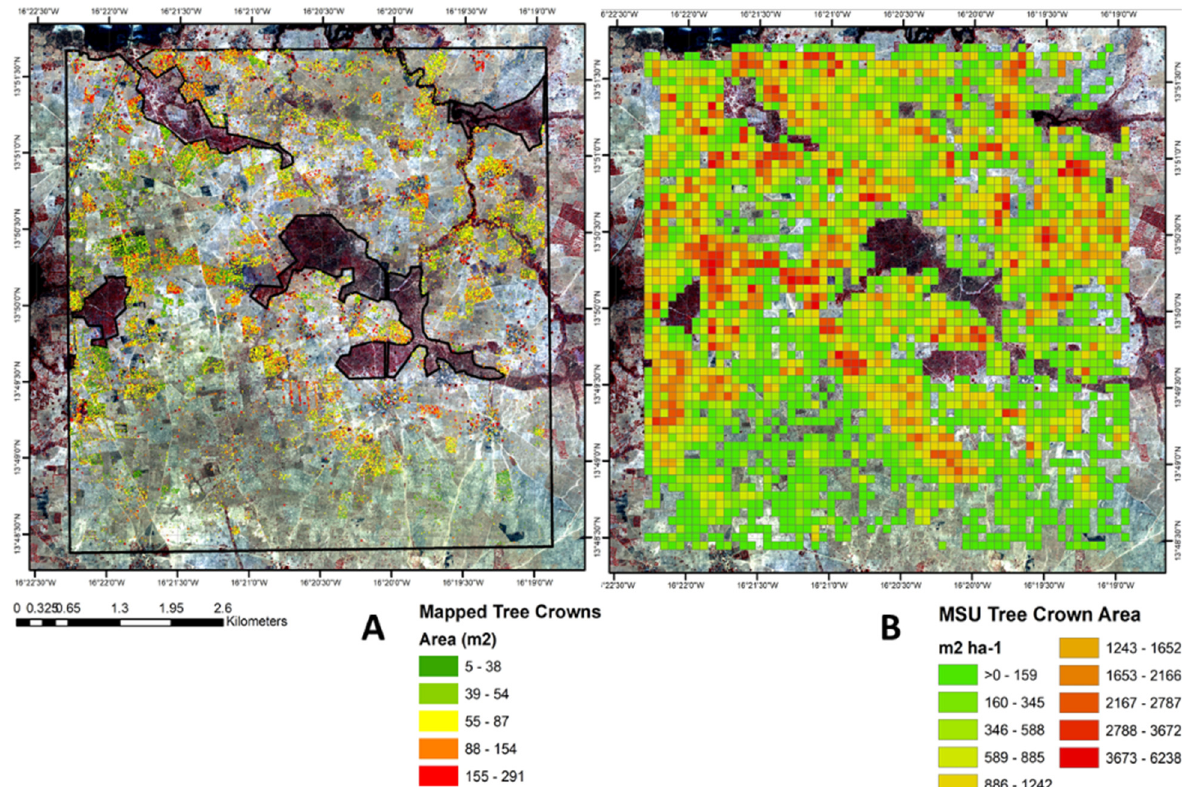
Figure 4. Tree cover mapping for the entire test site from mapping individual tree crown areas. ( A ) Individual trees mapped at the original 0.5 m spatial resolution, color-coding represents the cover area per tree (m 2 per tree). ( B ) Mapping cover density at the 1 ha level, produced by the summation individual tree crown projected area for all trees in the 1 ha grid cell (m 2 ha − 1 ). Table 3. Tree crown area (m 2 ), DBH (cm), and carbon (Mg) descriptive statistics. This